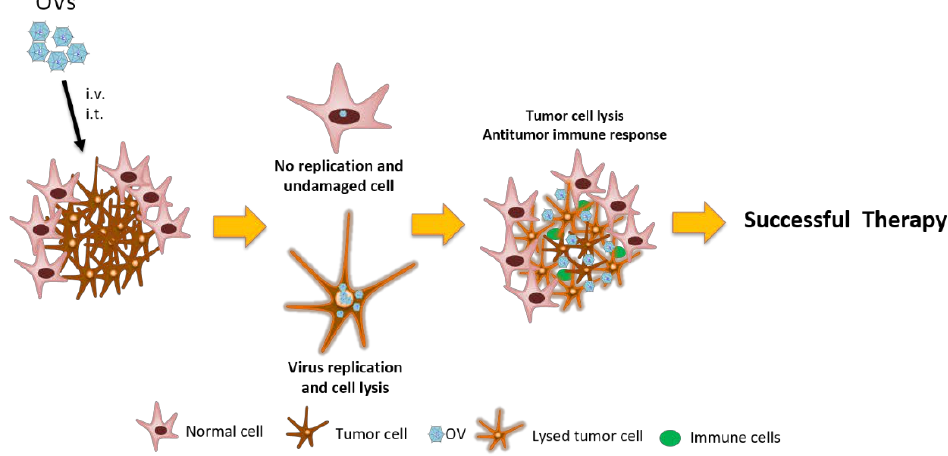
Figure 1. Mechanism of antitumoral effect of oncolytic viruses (OVs). The administration of OVs could be intravenous or intratumoral. Once the virus reaches the tumor is able to infect both normal and tumor cells but only replicates and lyses the tumor cells. Besides the potent cytolytic effect of the virus, the generation of an antitumor immune response is crucial to the complete eradication of the